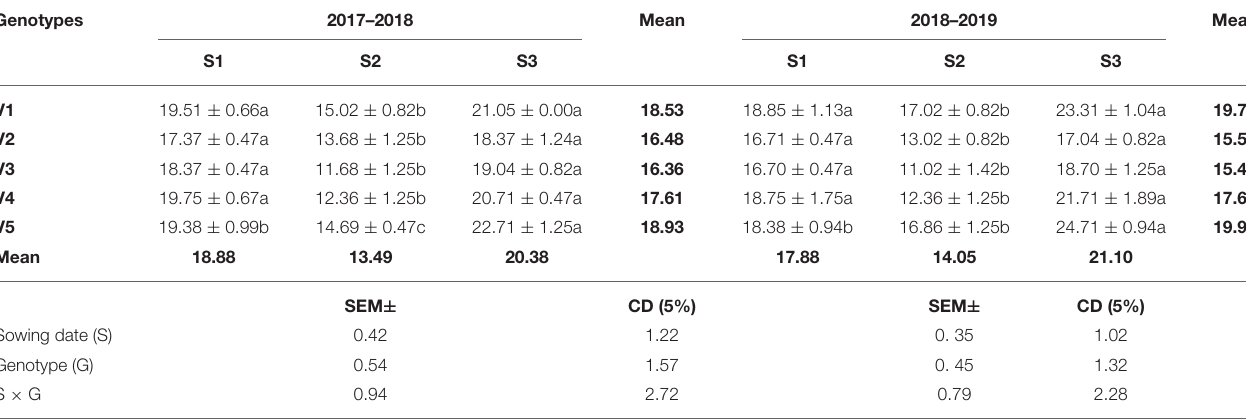
TABLE 6 | The CAT activity (EU mg − 1 protein min − 1 ) at mid-flowering stage in top leaf of mustard varieties sown at three different dates during rabi 2017–2018 and 2018–2019.